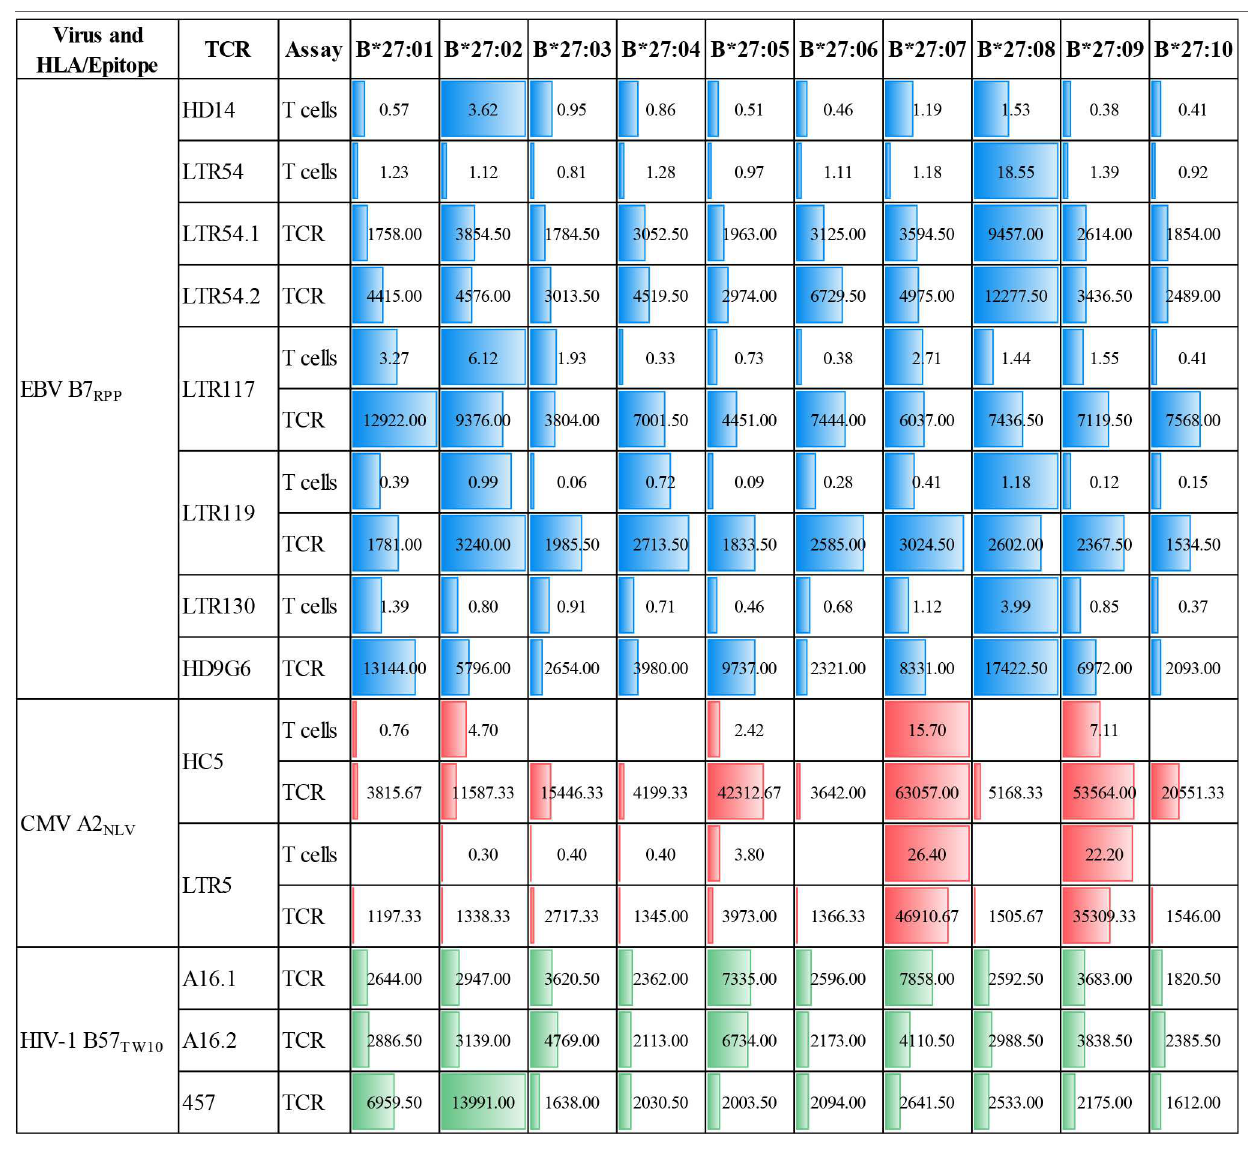
TABLE 2 | Comparison of T cell cross-reactivity using cellular